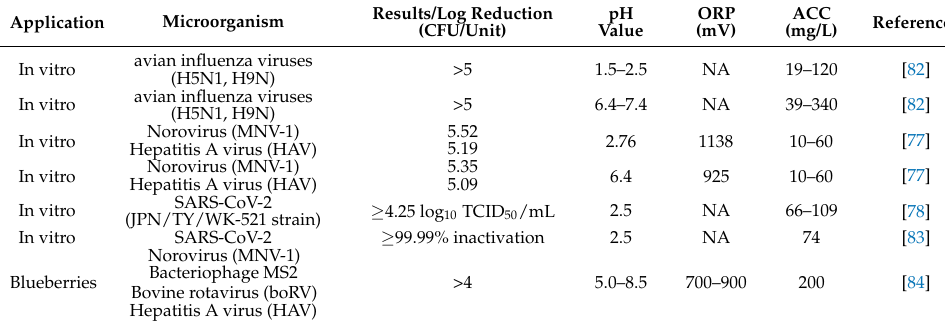
Table 8. Summary of AEW and WAEW’s antiviral